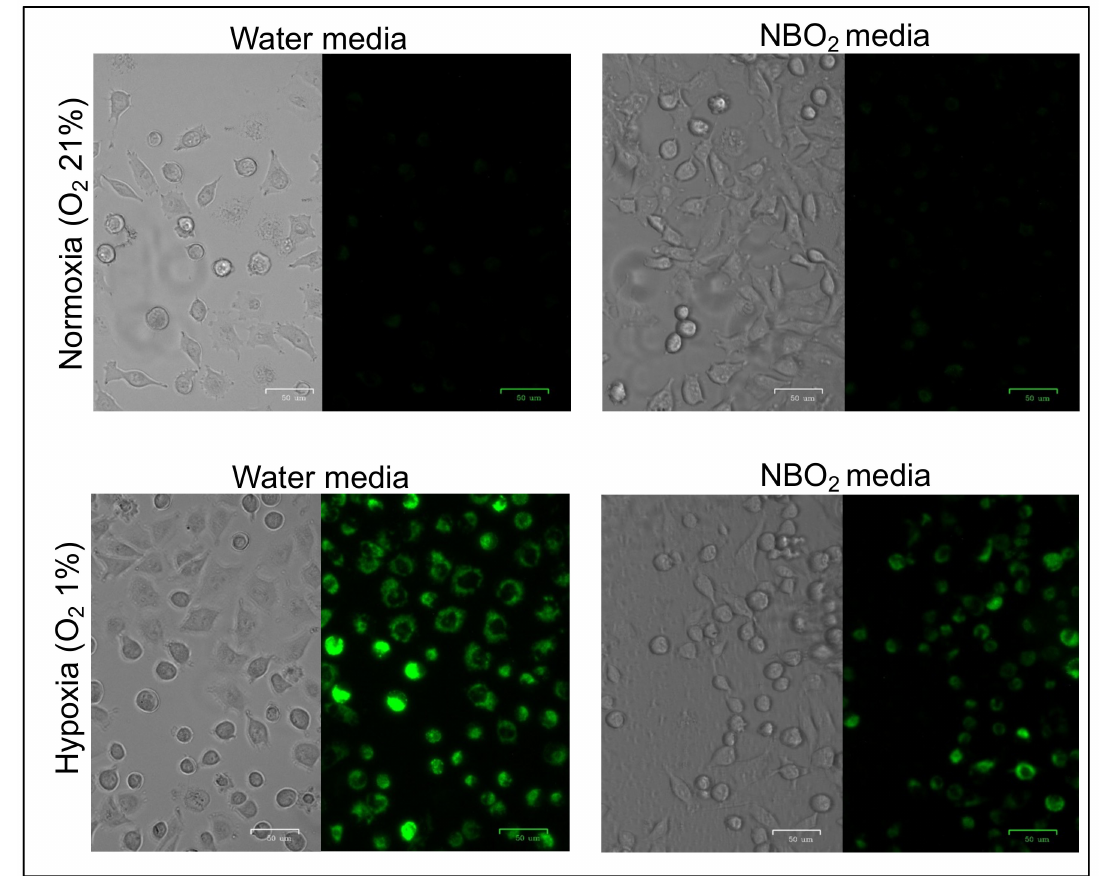
Figure 1. Suppression effect of hypoxia/HIF after treatment with NBO 2